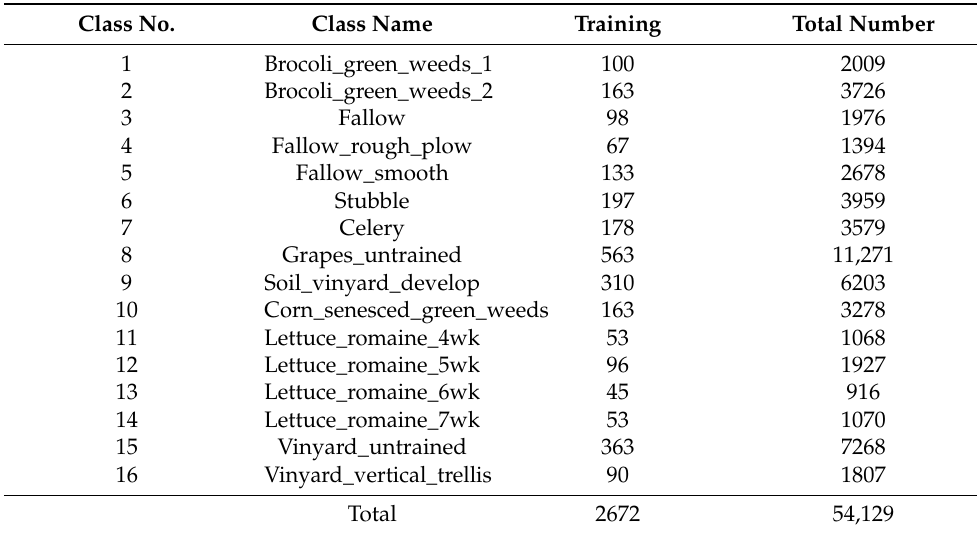
Table 2. Land-Cover Classes of The Salinas Data Set Class